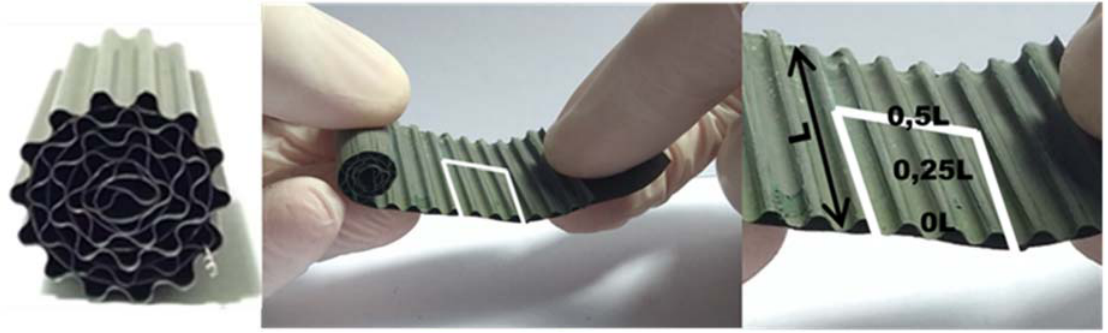
Figure 3. Illustration of the studied area of each monolith for SEM and EDX.